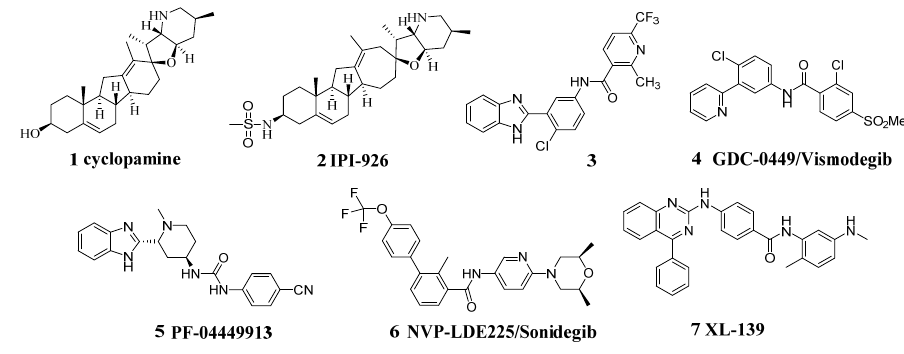
Figure 1. Promising Smo inhibitors.